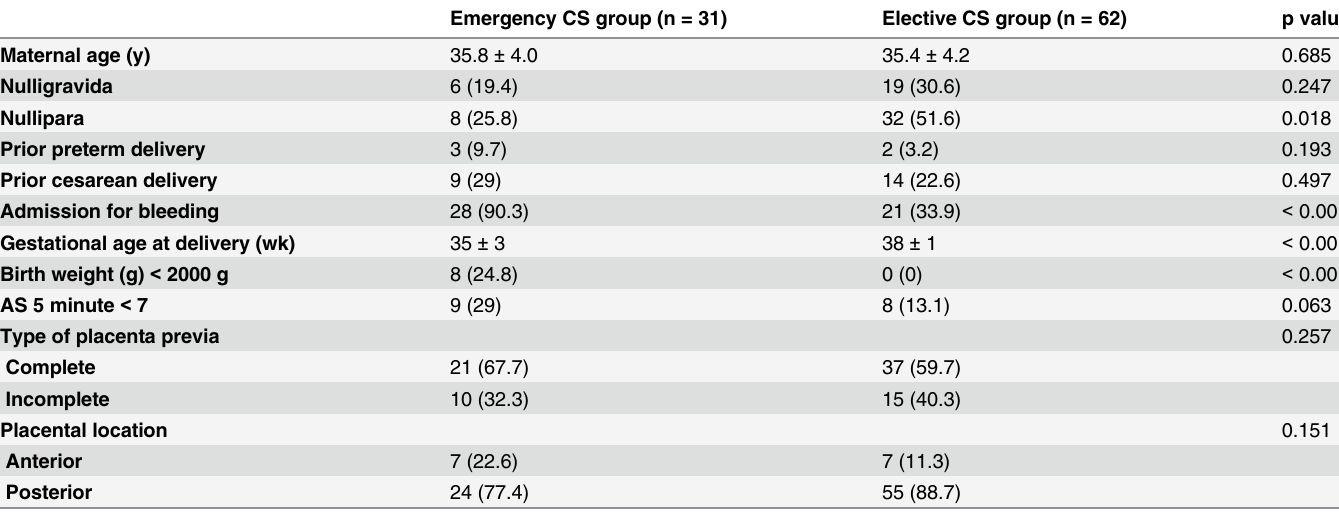
Table 1. Clinical characteristics of the